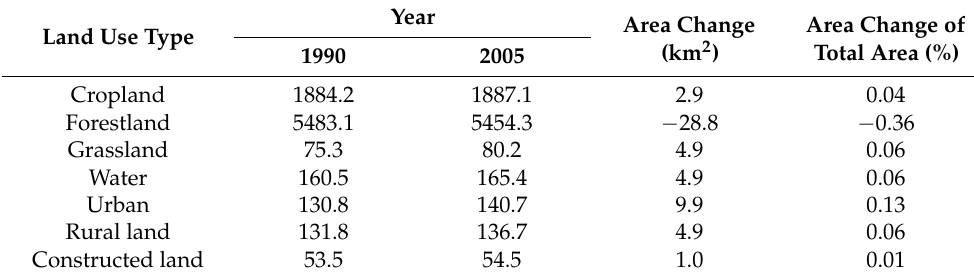
Table 4. Statistics for land use type changes in the HRB during